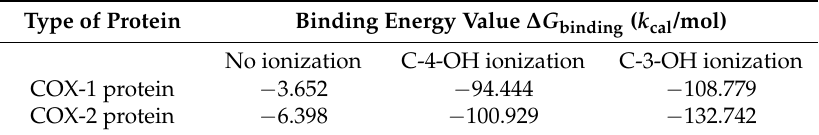
Table 1. Computed binding energy values ( ∆ G binding , k cal /mol) for the molecular docking analysis of the best binding poses between ethyl gallate (partially-ionized vs non-ionized) and cyclooxygenase 1 and 2 (COX-1 and COX-2)